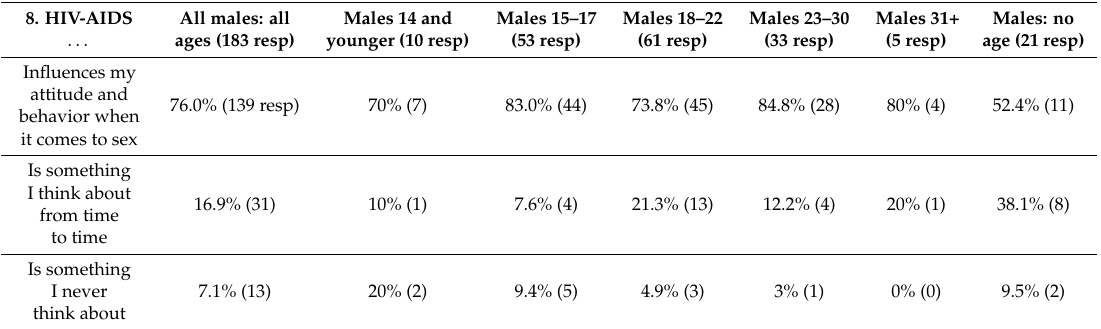
Table 14. Influence of HIV-AIDS on Attitudes and Behavior about Sex—All Females. 8. HIV-AIDS